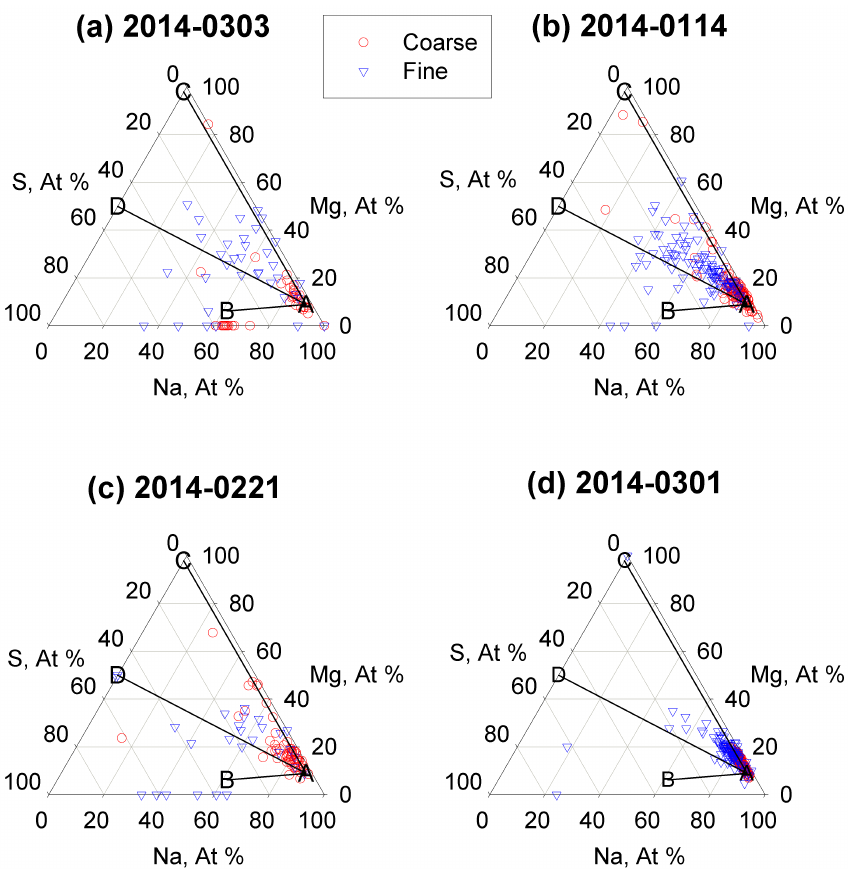
Figure 10. Ternary plots of Na–Mg–S of sea-salt particles and the modified sea-salt particles collected over the sea-ice area: (a) 3 March 2014, (b) 14 January 2014, (c) 21 February 2014, and (d) 3 January 2014. Letters A, B, C, and D within each panel denote, respectively, the ratios of seawater and those fully modified with SO 2 − , MgCl 2 , and MgSO 4 . Red open circles and blue triangles respectively present ratios 4 of particles in coarse and fine modes. The notation “At %” stands for atomic ratio (in